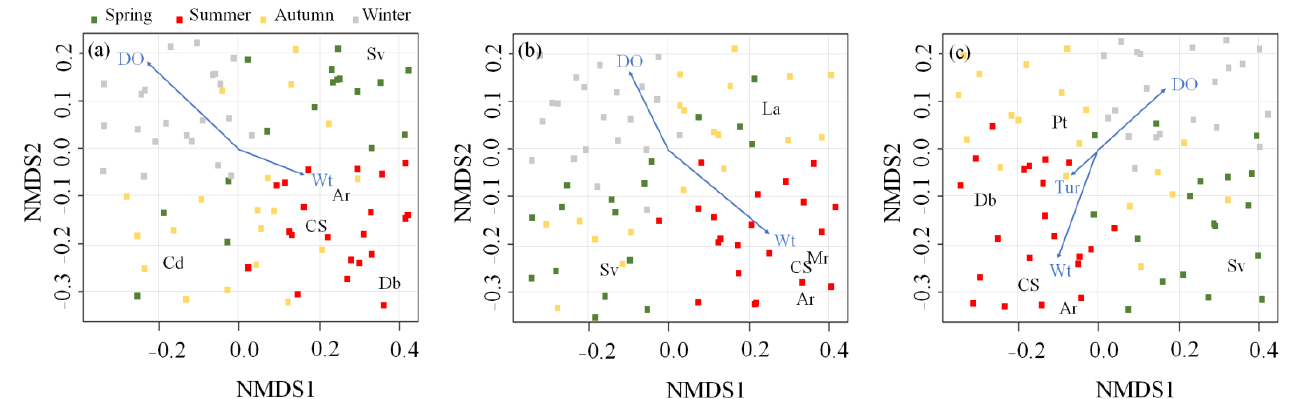
Figure 3. Non-metric multidimensional scaling (NMDS) of five dominant rotifer species (letters) and 79 sampling times (dots). Blue arrows represent the associations with environmental variables. Sampling times are divided into four seasons (spring, summer, autumn, and winter). Wt: water temperature; DO: dissolved oxygen; Tur: turbidity; Cs: Chydorus shpaericus ; Ar: Alona retangula ; Sv: Simocephalus vetulus ; Db: Diaphanozoma brachyrum ; Mr: Macrotrix rosea ; Cd: Ceriodaphnia dubia ; La: Latonopsis australis ; Pt: Pleuroxus trigonellus . ( a ) Upo Wetland, ( b ) Jangcheok Wetland, and ( c ) Beongae Wetland.